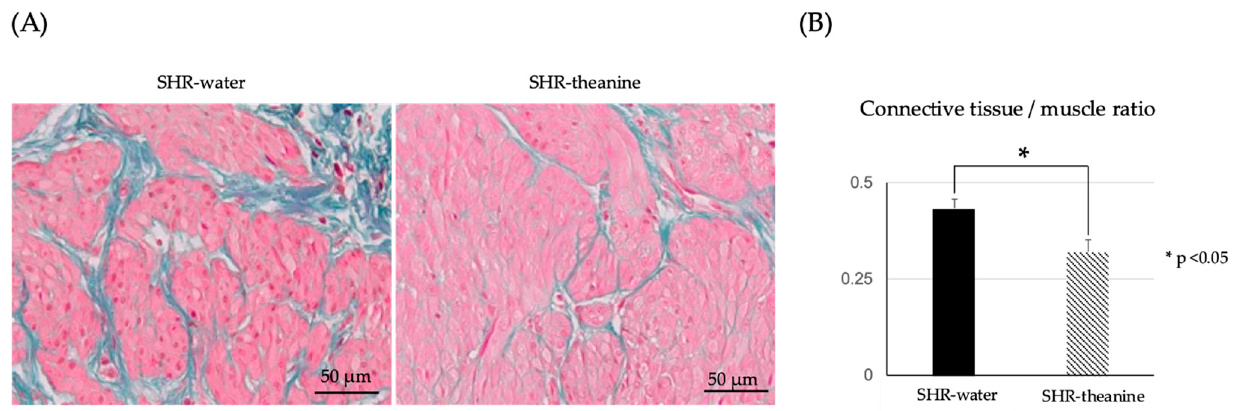
Figure 7. Bladder smooth muscle to connective tissue ratio in the SHR-water and SHR-theanine groups: ( A ) Elastica– Masson staining of the detrusor smooth muscle layer of the bladder in SHR treated with water and treated with L -theanine. Scale bars = 50 µM; ( B ) the connective tissue-to-muscle ratio is significantly lower in the SHR–theanine group than in the SHR–water group. * Statistical significance at the p < 0.05 level.